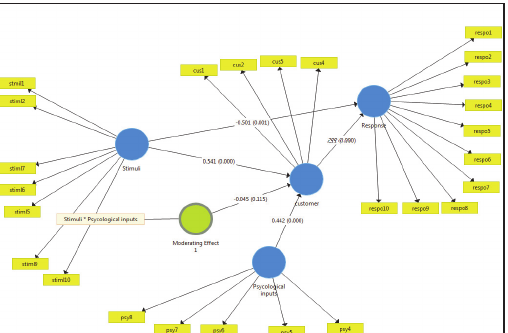
Fig. 4. Bootstrapping (beta and sig value) for Stimuli factors (marketing inputs, external environment), response purchase decisions for HVs & EVs consumers, positive psychological